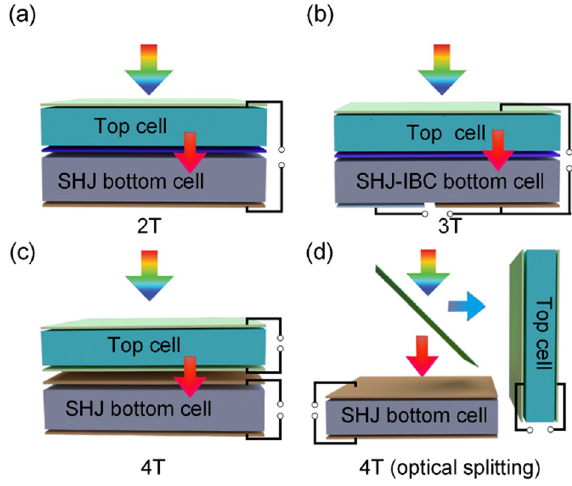
Figure 1: Structural sketches of four kinds of tandem solar cells